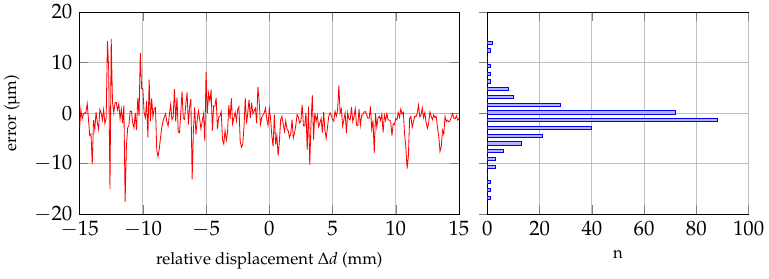
Figure 10. Measurement error over reference value ∆ d and the absolute quantity error